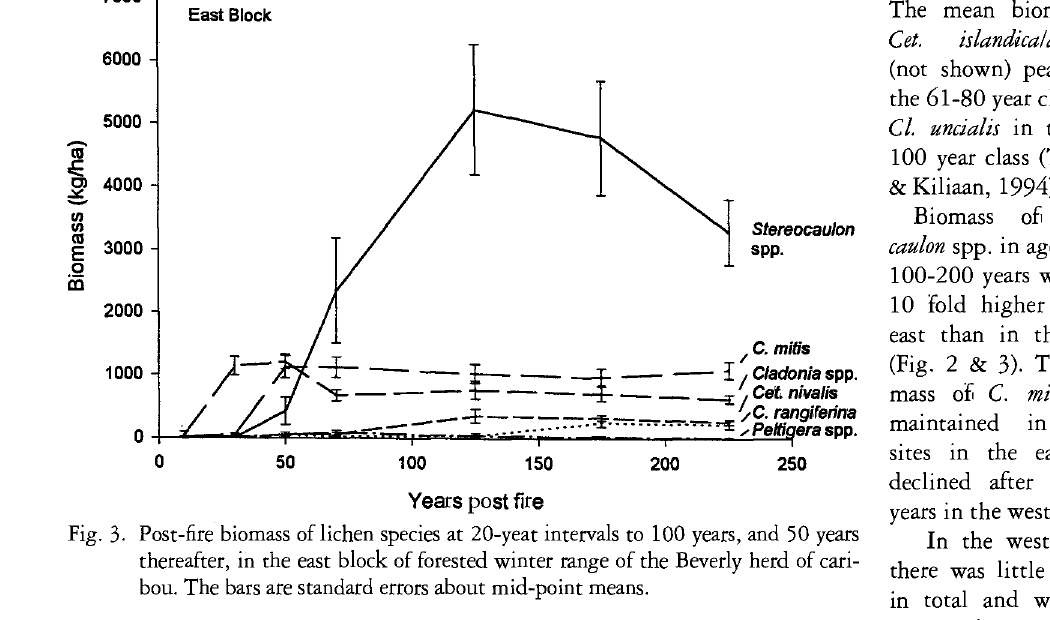
Fig. 3. Post-fire biomass of lichen species at 20-yeat intervals to 100 years, and 50 years thereafter, in the east block of forested winter range of the Beverly herd of cari bou. The bars are standard errors about mid-point means.